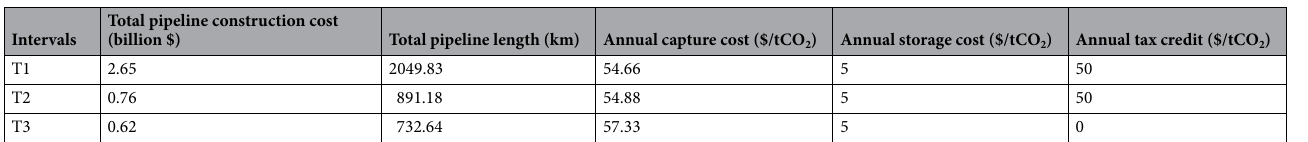
Table 8. Summary of final optimization solution for the I-WEST case